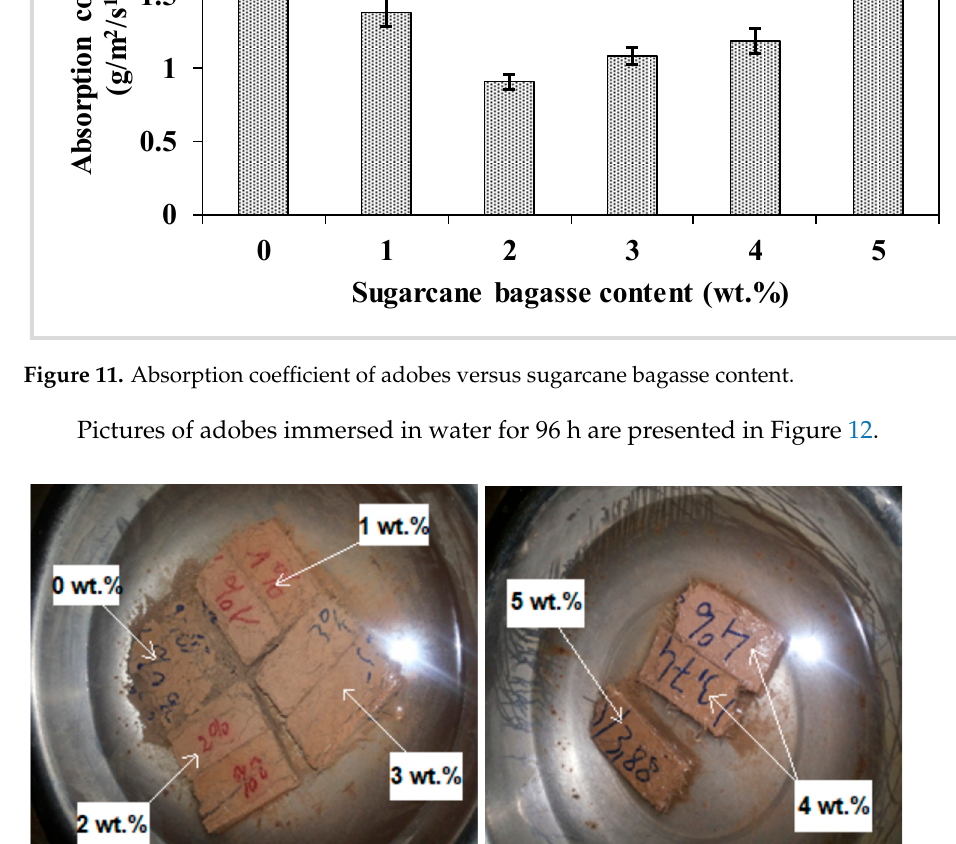
Figure 12. Adobes after 96 h of immersion.